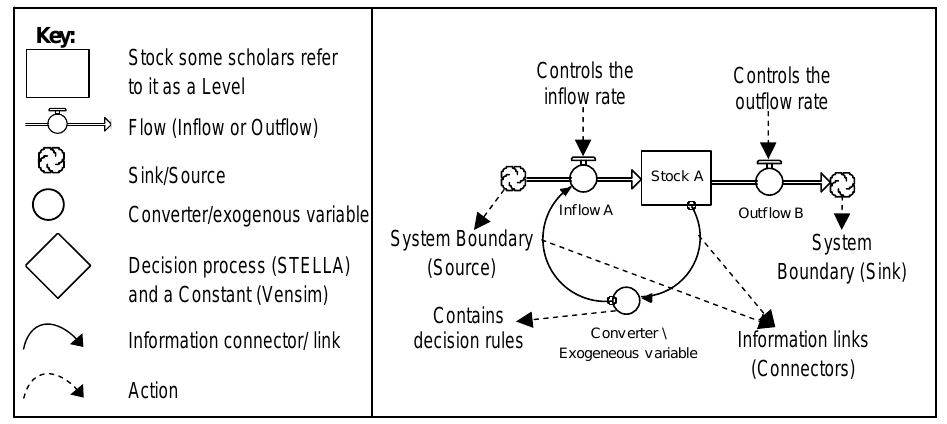
Figure 5. A summary of SFD basic building block (Source: